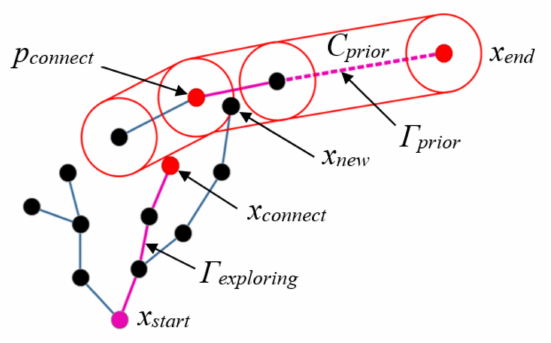
Figure 12. The shortest Γ exploring .